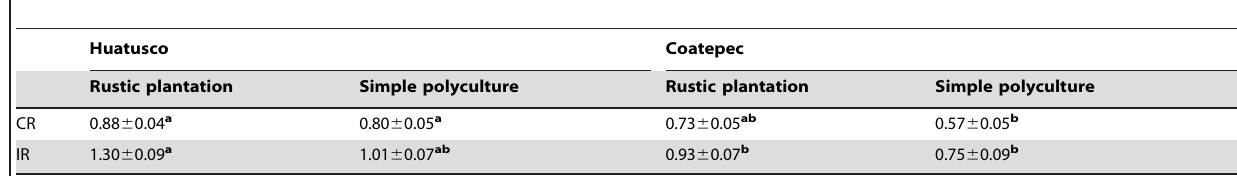
Table 1. Colonization rate (CR) and isolation rate (IR) of endophytic fungi in the four coffee plantations.